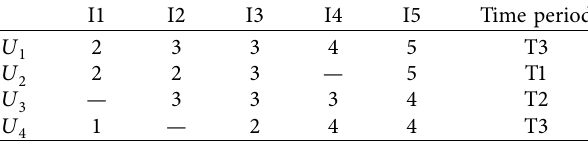
Table 1: Scores in different scoring time periods.